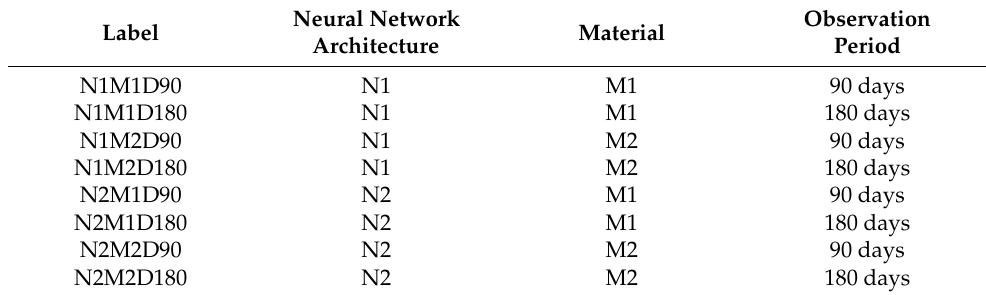
Table 2. Labels of performance test for inverse estimation.